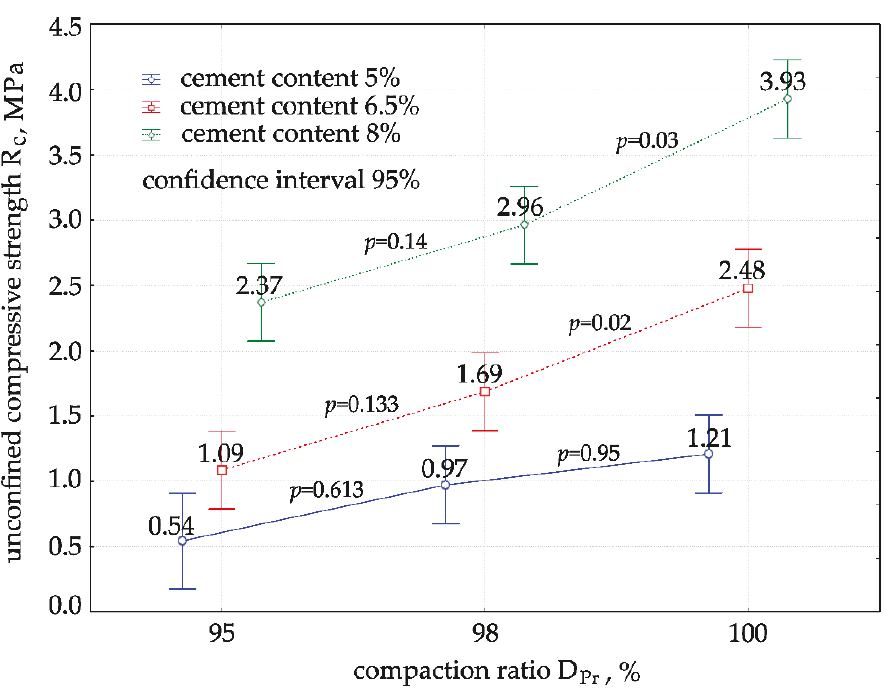
Figure 5. Diagram of variance of R c values and significance of differences between pairs of means.